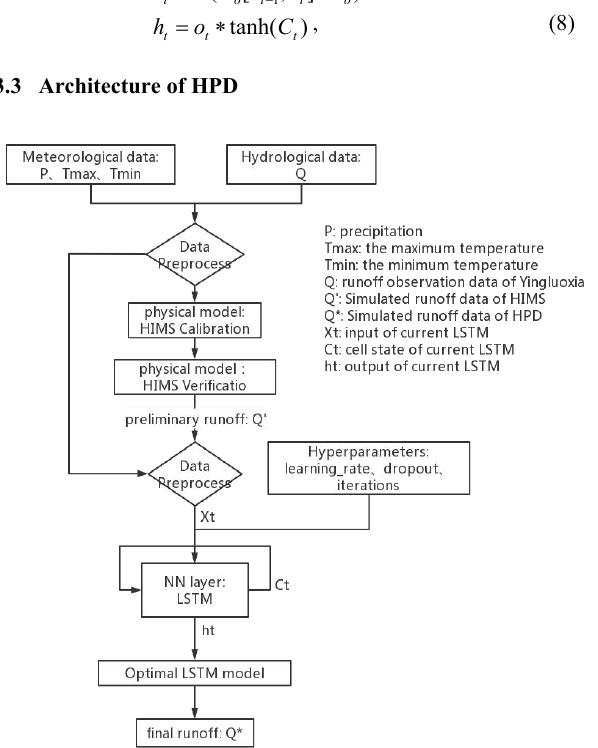
Figure 2 . A schematic illustration of a hybrid-physics-data (HPD)